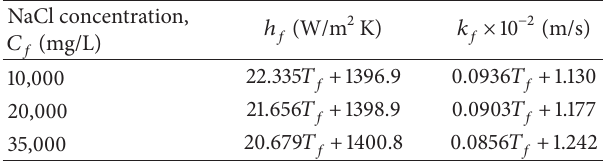
Table 3: Derived heat and mass transfer coefficients of saline